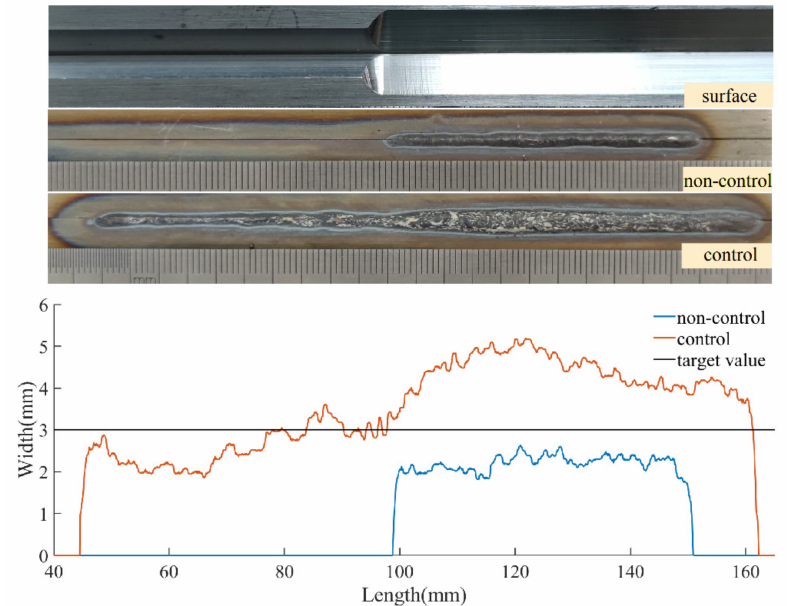
Figure 9. Comparison of results of the bottom molten pool width of the butt welding with the first half of the groove angle of 45 ◦ and the latter half of the groove angle of 30 ◦